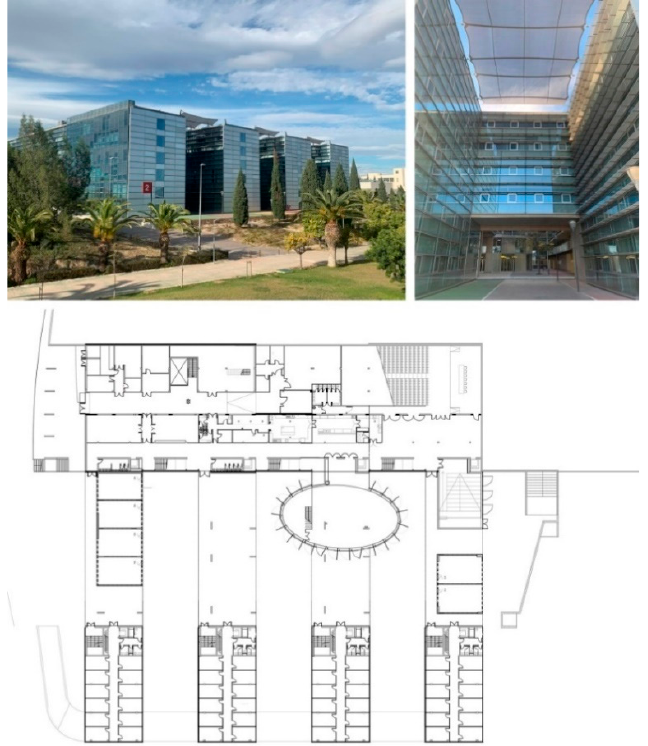
Figure 15. Photos and ground floor of the FEB, University of Murcia. Photos: Authors. Drawing: University of Murcia Technical Division.